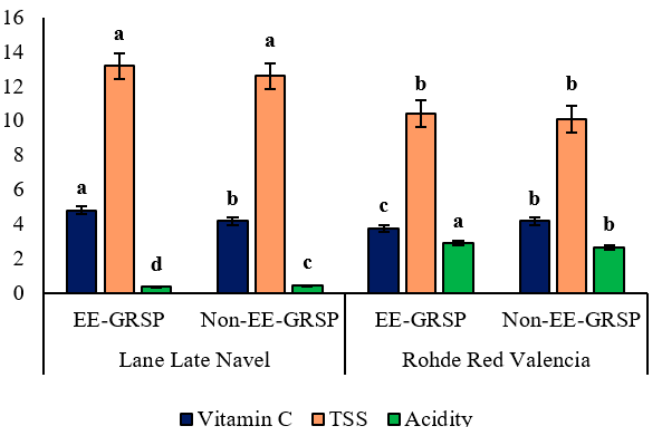
Figure 1. Effects of exogenous easily extractable glomalin-related soil protein (EE-GRSP) on Vitamin C (mg/g), total soluble solid (%), and titrable acidity (%) of fruits of Lane Late Navel (LW) and Rohde Red Valencia (XC) varieties of sweet orange. Data (means ± SD, n = 5) followed by different letters at the bar indicate significant differences ( p < 0.05) among treatments.